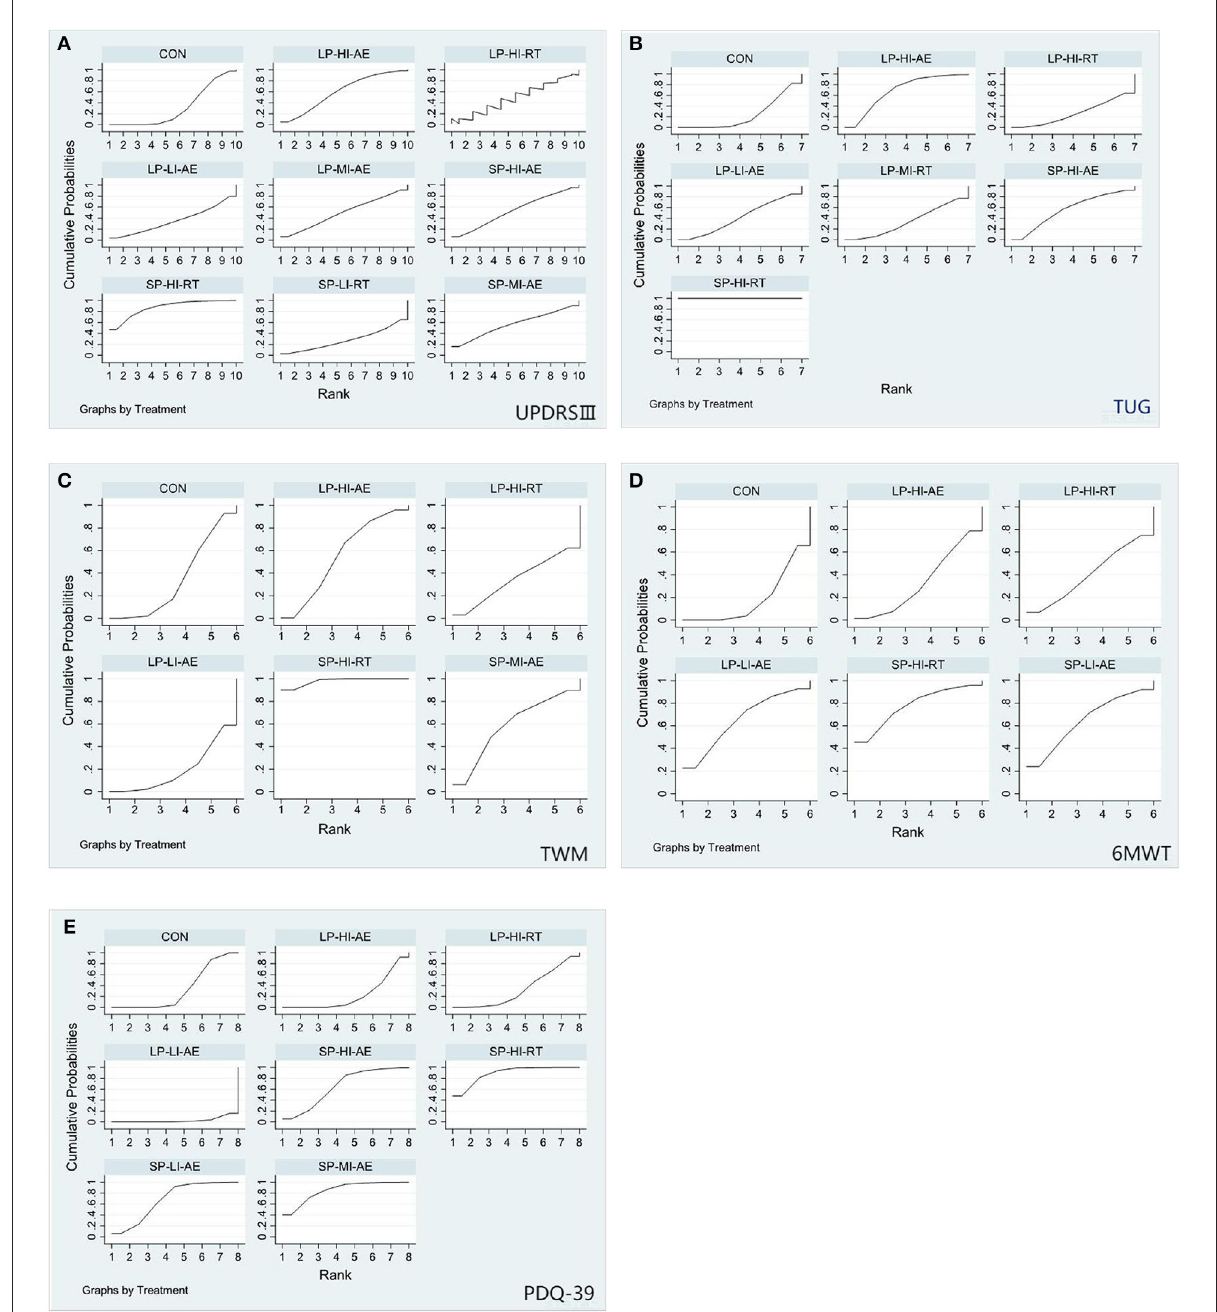
FIGURE5 The rank probability of various interventions based on the SUCRA [ (A) UPDRS-III outcome; (B) TUG outcome; (C) TWM outcome; (D) 6MWT outcome; (E) PDQ-39 outcome; SP-LI-AE, short period low intensity aerobic exercise; SP-HI-RT, short period high intensity resistance training; SP-HI-AE, short period high intensity aerobic exercise; SP-LI-RT, short period low intensity resistance training; LP-LI-AE, long period low intensity aerobic exercise; LP-HI-RT, long period high intensity resistance training; LP-HI-AE, long period high intensity aerobic exercise; LP-MI-AE, long period moderate intensity aerobic exercise; CON, control group].